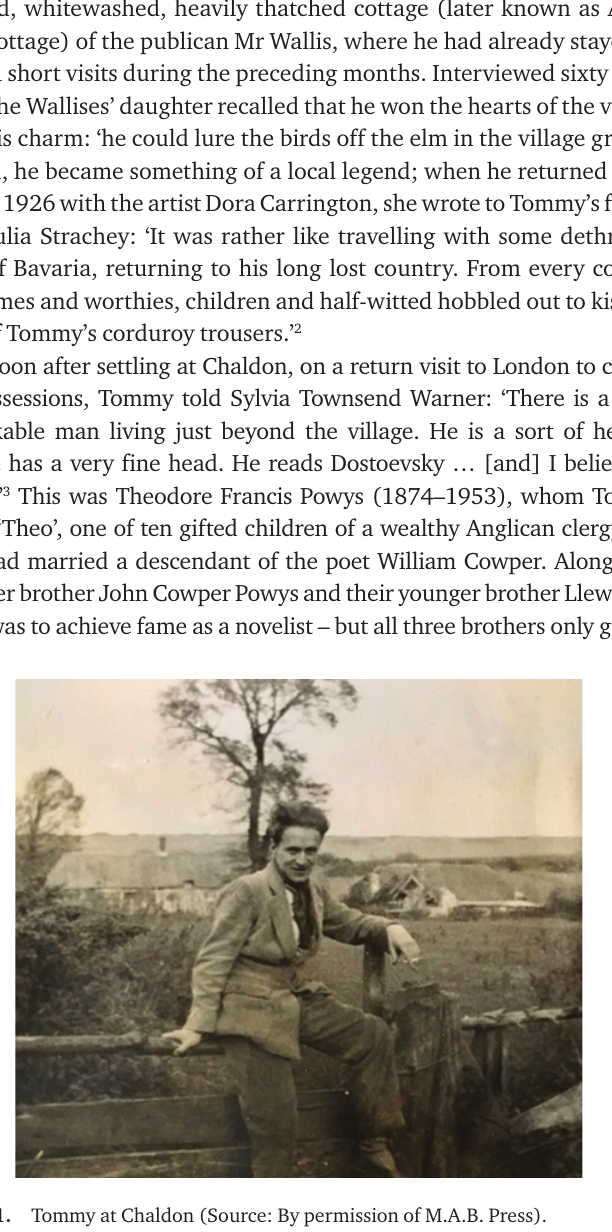
Figure 1. Tommy at Chaldon (Source: By permission of M.A.B.